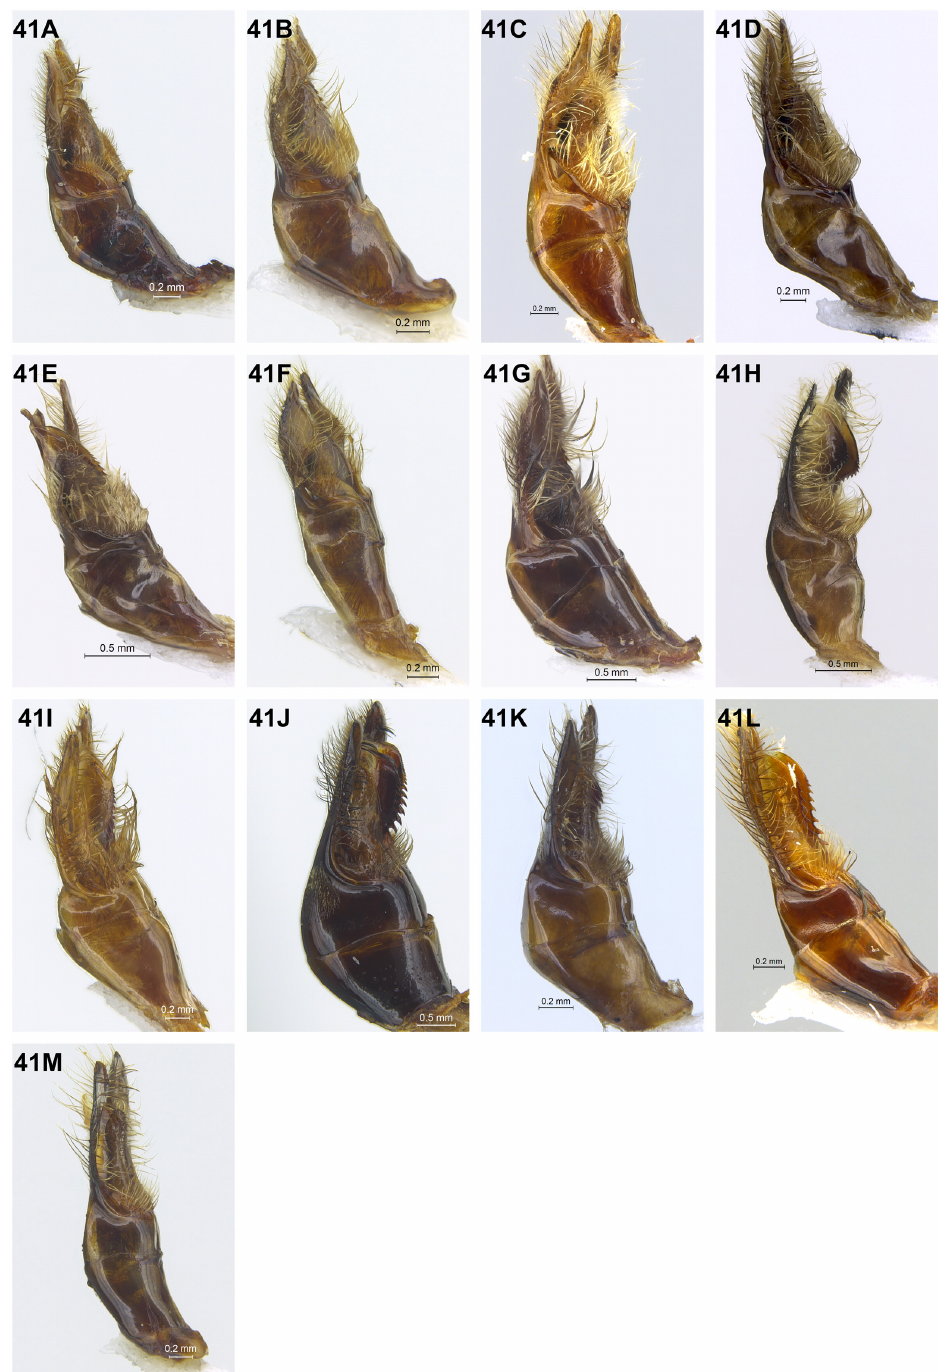
Fig. 41. Males genital capsule, lateral view. A . Campsomeriella annulata annulata (Fabricius, 1793). B . Camps. collaris (Fabricius, 1775). C . Megacampsomeris sp. 1. D . Megacam. formosensis